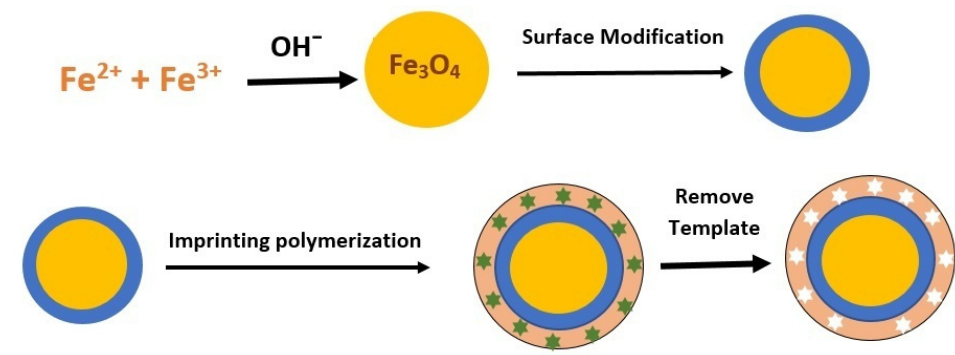
Figure 1. The general steps in the preparation of magnetic molecularly imprinted polymer.